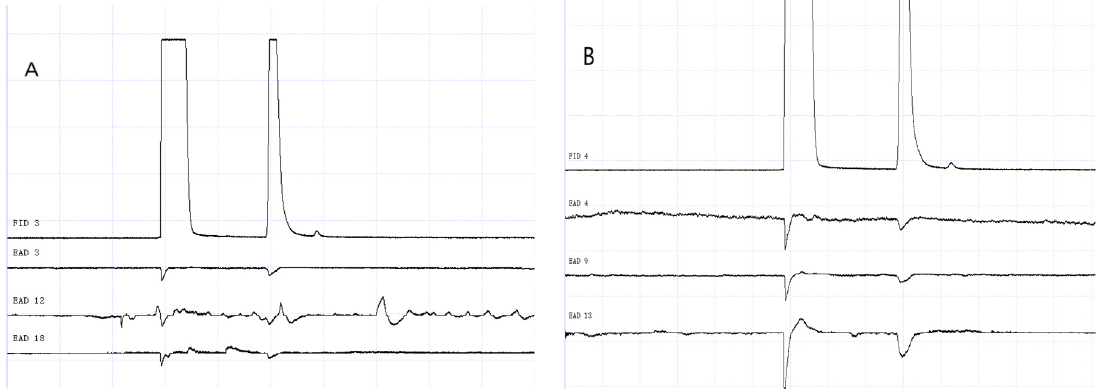
Figure 16. GC-EAD responses of 7-day-old W. magnifica to 1-octen-3-ol. ( A ) Male. ( B ) Female.